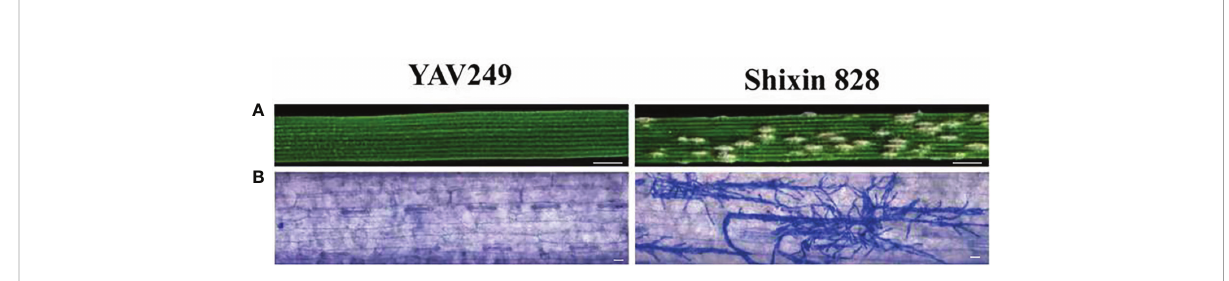
FIGURE 1 Macroscopic and microscopic characterization of YAV249 and Shixin 828 after inoculating isolate E09 of Blumeria graminis (f) sp. tritici ( Bgt ). (A) Macroscopic view of the infected representative leaf segments from YAV249 and Shixin 828 at 10 d post-inoculation (dpi). Bar, 5 mm. (B) Microscopic view of leaves from YAV249 and Shixin 828 at 7 dpi to visualize fungal mycelia. Bar, 100 m